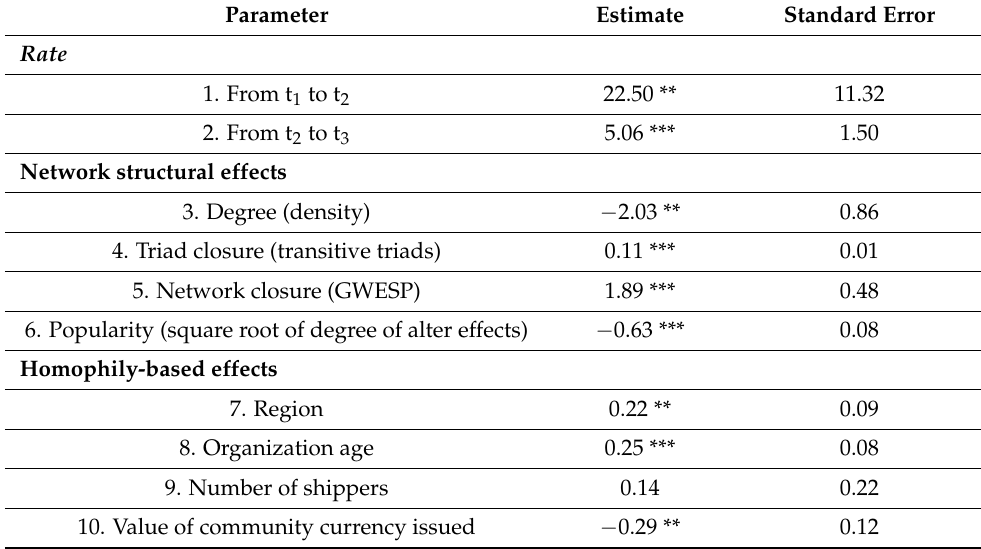
Table 3. Results of the stochastic actor-oriented model testing the formation of policy communication networks among Ki-no-Eki